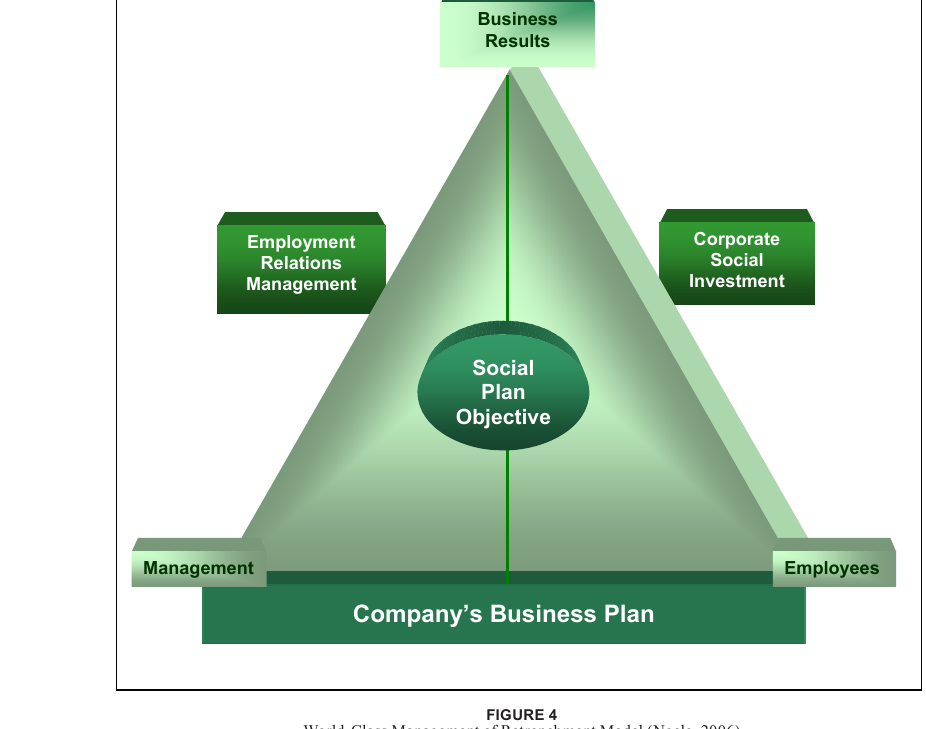
Figure 4 World-Class Management of Retrenchment Model (Ngele,